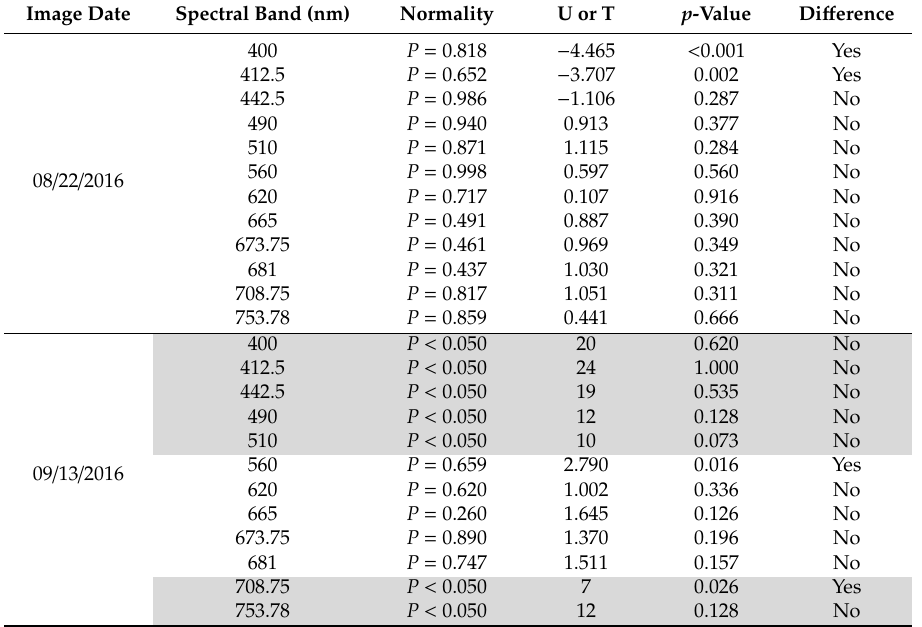
Table 2. Statistical di ff erences between spectral bands from the two atmospheric correction procedures.